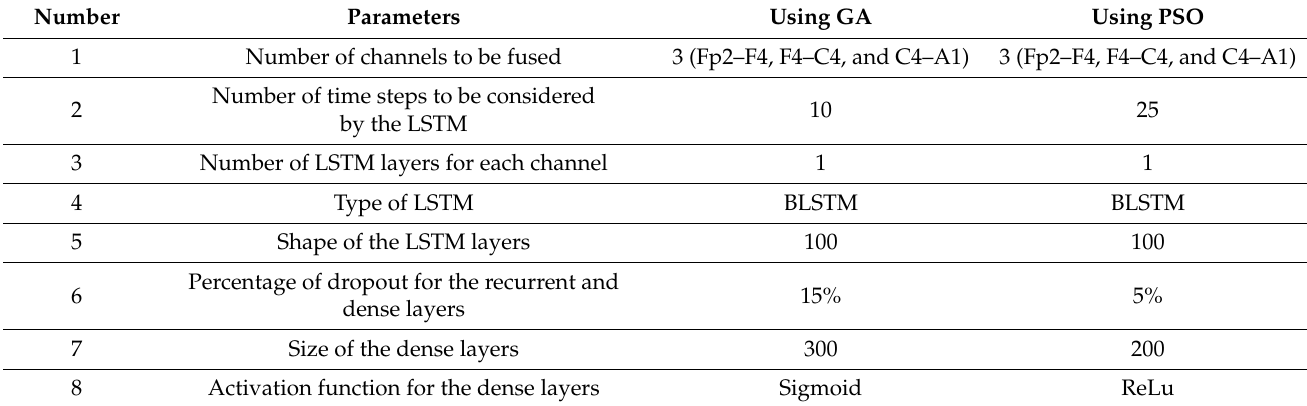
Table 2. Optimal configurations found by the optimization algorithms.